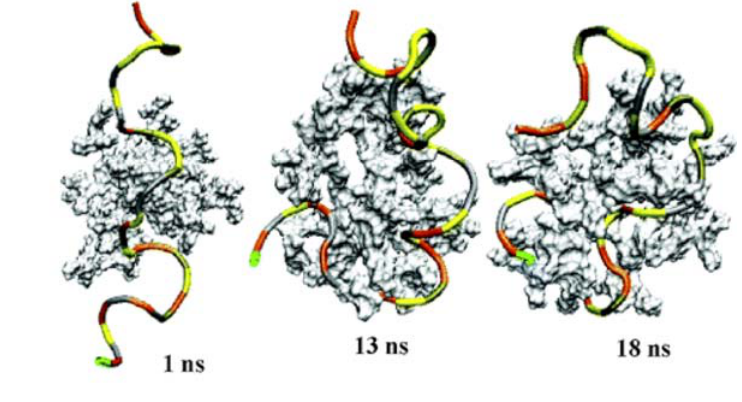
Figure 8 . Snapshots every few ns of formation of an ssDNA-dendrimer complex. Reprinted with permission from [41]. Copyright 2006 American Chemical